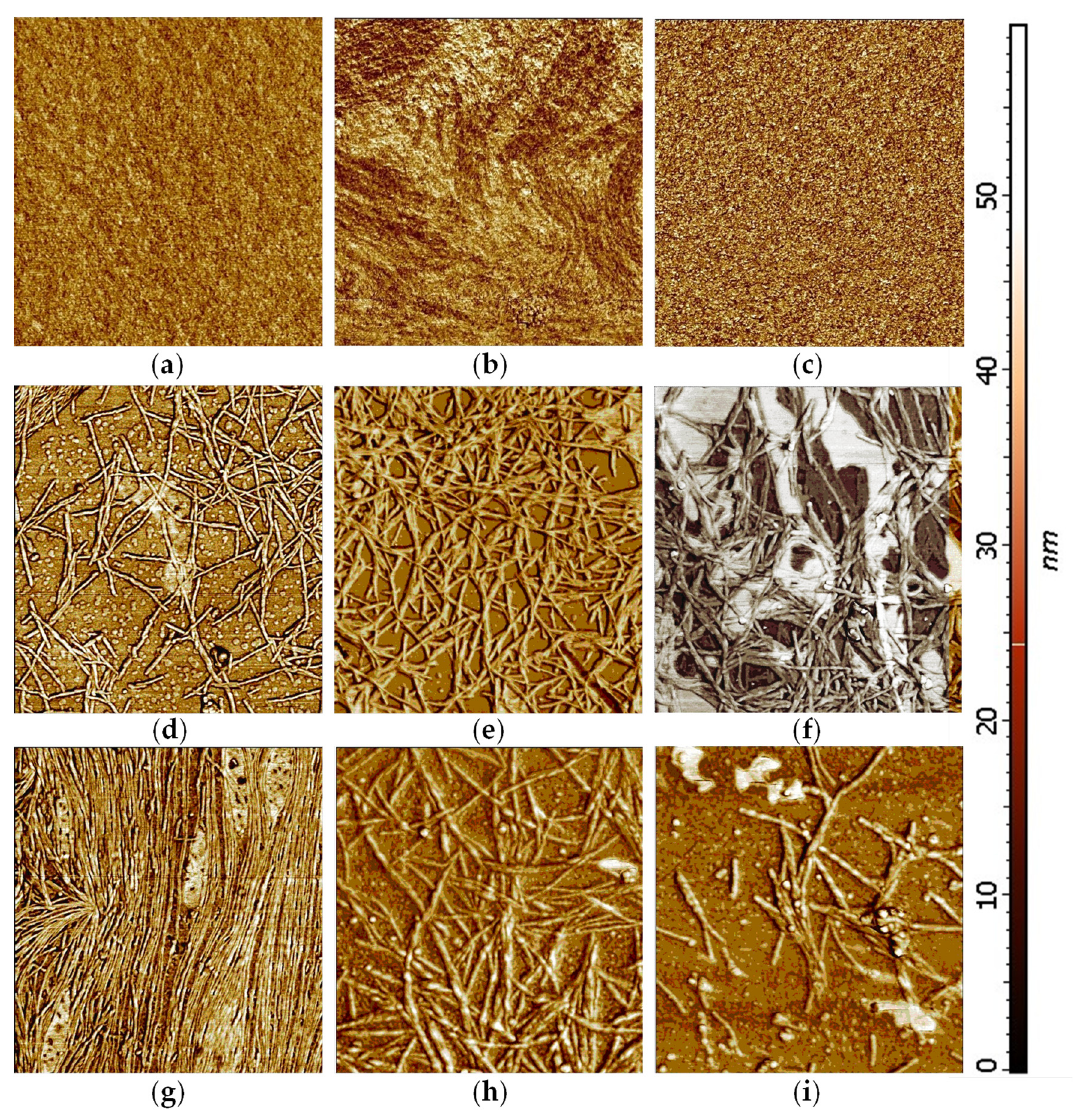
Figure10. Atomicforcemicroscopy(AFM)imagesoffilmsurfacesofpeptidecomplexeswithaluminium Figure 10. Atomic force microscopy (AFM) images of film surfaces of peptide complexes with ions. ( a ) Free A β (1–16) ; ( b ) A β (1–16) + Al 2 (SO 4 ) 3 , 1:1 molar ratio; ( c ) A β (1–16) + Al 2 (SO 4 ) 3 , 1:2 molar aluminium ions. ( a ) Free A β (1 – 16) ; ( b ) A β (1 – 16) + Al 2 (SO 4 ) 3 , 1:1 molar ratio; ( c ) A β (1 – 16) + Al 2 (SO 4 ) 3 , 1:2 ratio; ( d ) free A β (1–16) A 3 6,13,14 ; ( e ) A β (1–16) A 3 6,13,14 + Al 2 (SO 4 ) 3 , 1:1 molar ratio; ( f ) A β (1–16) A 3 6,13,14 + molar ratio; ( d ) free A β (1 – 16) A 36,13,14 ; ( e ) A β (1 – 16) A 36,13,14 + Al 2 (SO 4 ) 3 , 1:1 molar ratio; ( f ) A β (1 – 16) A 36,13,14 + Al 2 (SO 4 ) 3 , 1:2 molar ratio; ( g ) free A β (1–16) S 3 6,13,14 ; ( h ) A β (1–16) S 3 6,13,14 + Al 2 (SO 4 ) 3 , 1:1 molar Al 2 (SO 4 ) 3 , 1:2 molar ratio; ( g ) free A β (1 – 16) S 36,13,14 ; ( h ) A β (1 – 16) S 36,13,14 + Al 2 (SO 4 ) 3 , 1:1 molar ratio; ( i ) A β (1 –